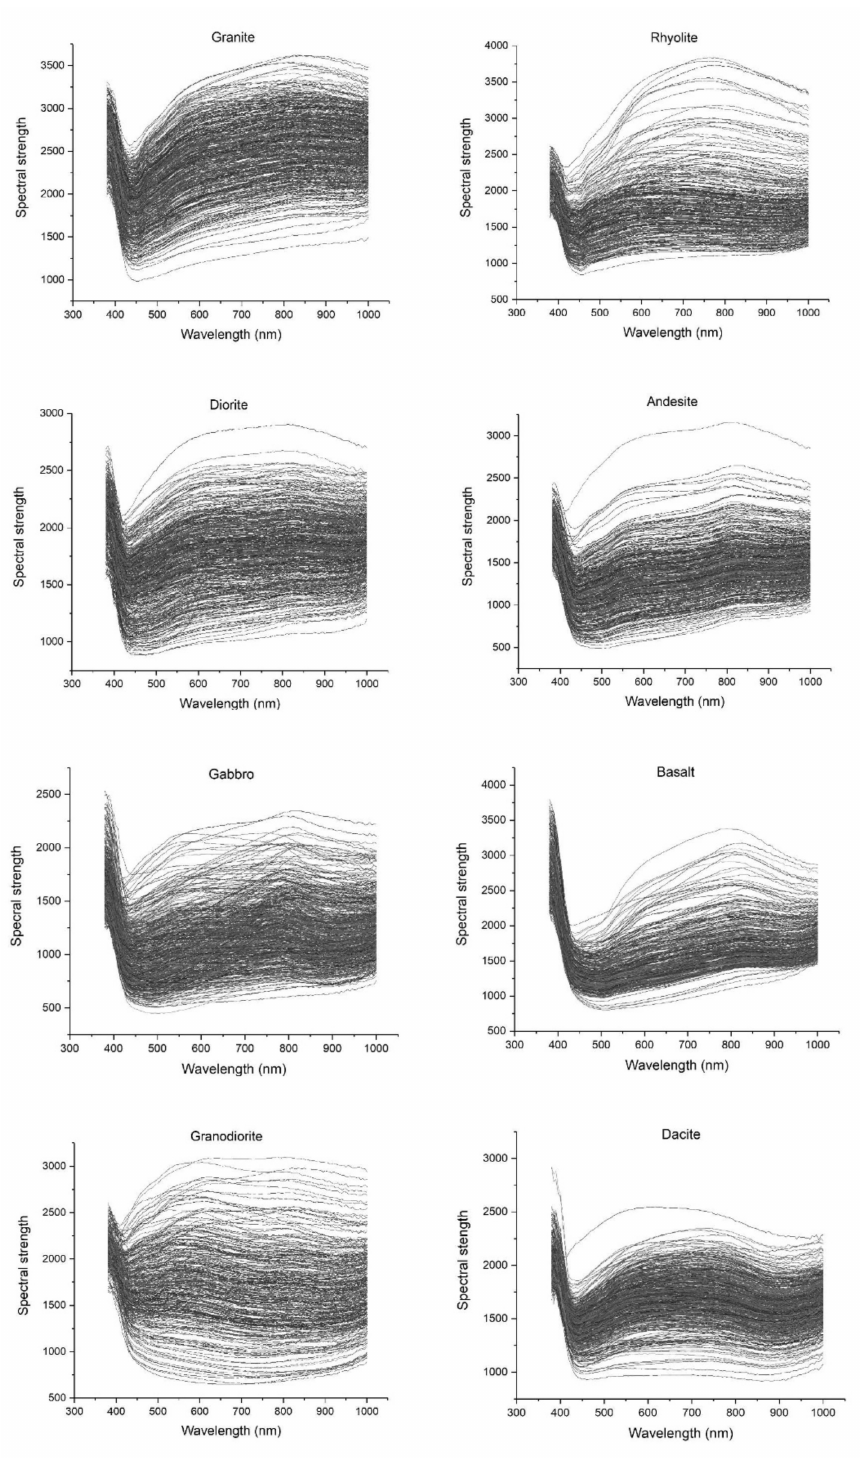
Figure 5. Reflectance hyperspectral signatures of eight rock lithologies employed in the construction of a hyperspectral database. Each anomaly represents the interaction between each 20 × 20 pixels 2D area with a depth of 204 bands within a rock’s hyperspectral image with light, captured via a Visible-Near-Infrared-Range hyperspectral